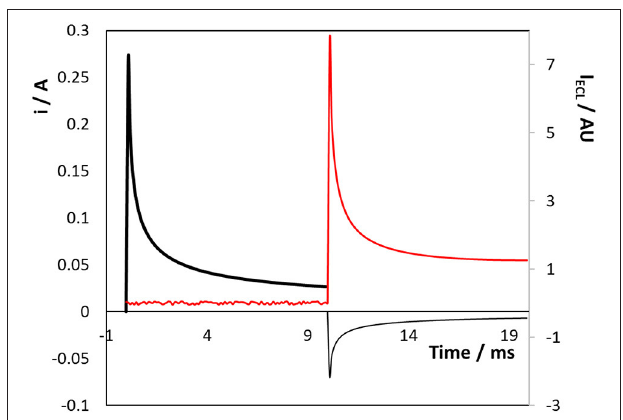
FIGURE 5 | Transient current (black line) and ECL (red line) responses for the 3D titanium array coated with a native oxide following potential steps from 0.000 to − 1.600V (Ru 2 + reduction, thick black line) and then to + 1.200V (Ru 2 + oxidation, thin black line) vs. Ag/AgCl. Reduction currents are positive.